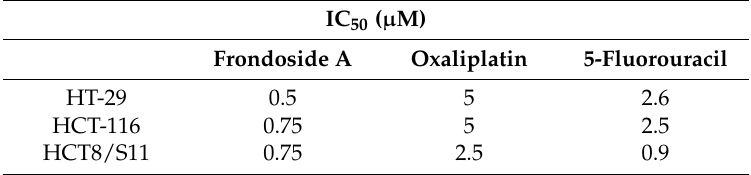
Table 1. IC 50 ( µ M) of Frondoside A compared to oxaliplatin and 5-fluorouracil at 48 h of treatment. IC 50 ( µ M) Figure 1. Frondoside A inhibition of colon cancer cell numbers compared to oxaliplatin and 5- fluorouracil. Exponentially growing HT-29 cells were treated with vehicle (0.1% DMSO) and the